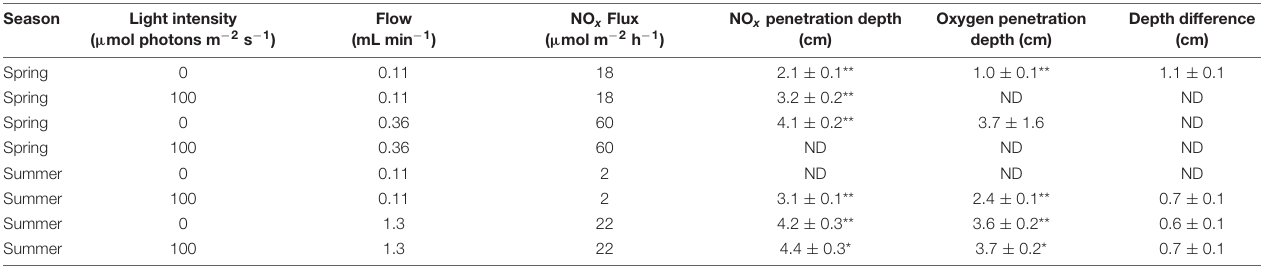
TABLE 1 | Theoretical maximum NO x and oxygen penetration depths and NO x fluxes, under different light and flow conditions.